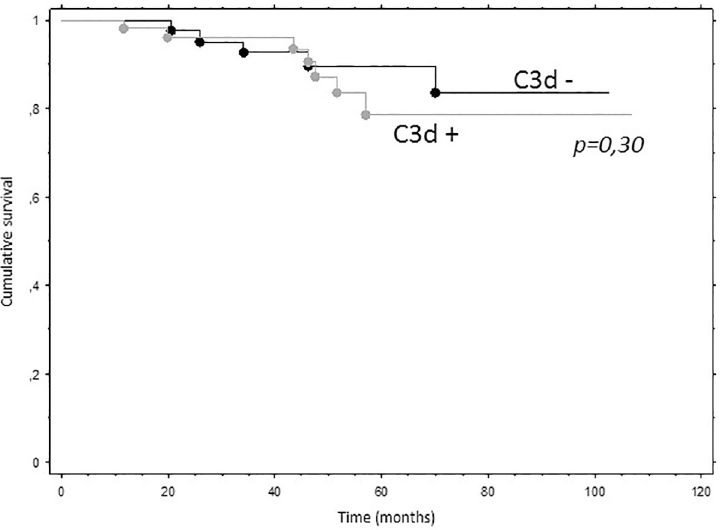
Fig 5. Death censored graft survival according to C3d-fixing DSA status. DSA: donor specific antibodies.